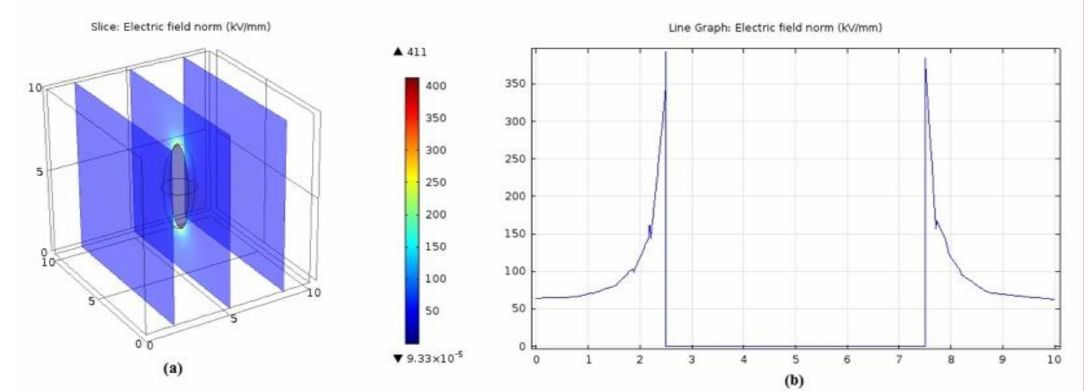
Figure 9. Mesh form of the model.